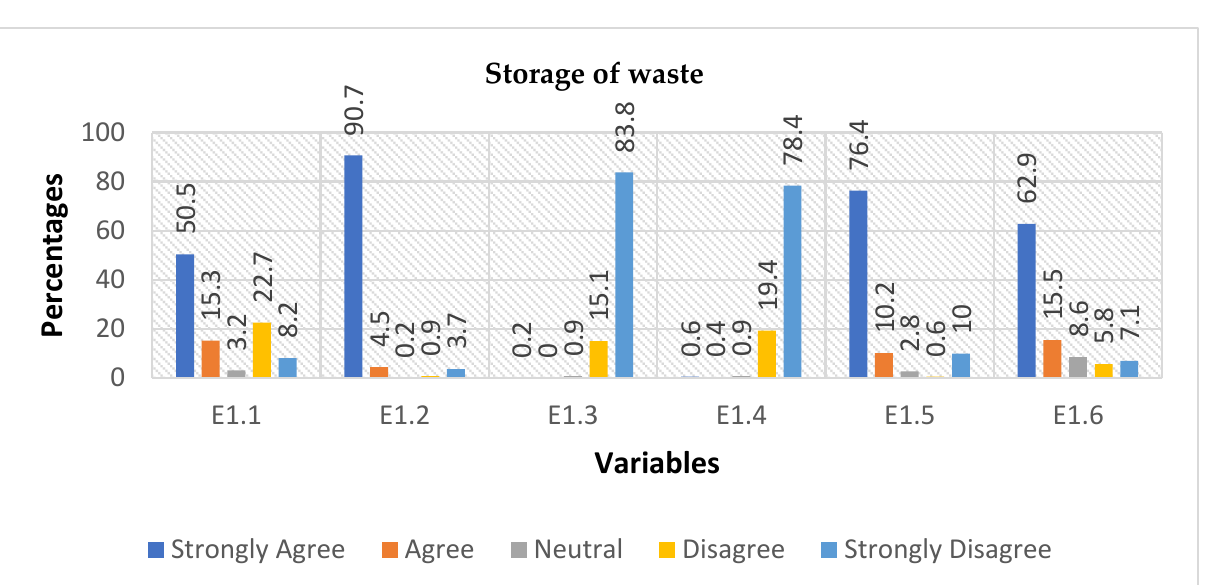
Figure 1. The illustration of how different types of waste can be useful to respondents if they keep it in their premises to be used in future. Variables are questions: E1.1 = Storage of waste, E1.2 = Cow dung as fuel, E1.3 = Cow dung for generator, E1.4 = Cow dung for lighting, E1.5 = Decomposed waste for manure, E1.6 = Production of new items.